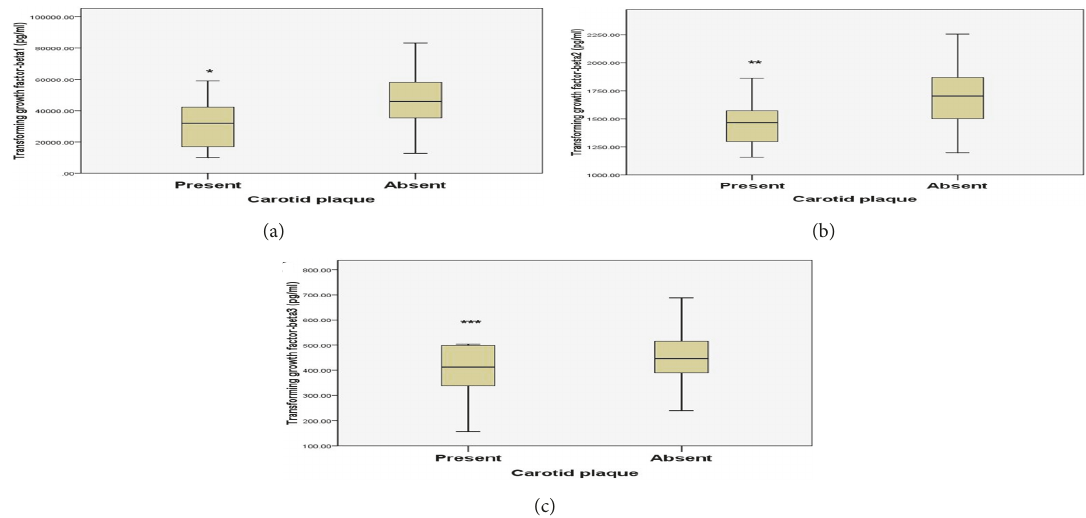
Figure 2: Comparison of serum transforming growth factor- 𝛽 1 (a), 𝛽 2 (b), and 𝛽 3 (c) between patients with carotid plaque and those without plaques. The boxes indicate median, 25th, and 75th percentile; whiskers represent data range; whisker caps indicate 5th and 95th percentile. Transforming growth factor- 𝛽 1, 𝛽 2, and 𝛽 3 levels were analyzed with Bio-Plex Pro (cid:3) TGF- 𝛽 Assays kit. Carotid plaque was defined as the echogenic structure protruding into the lumen with the distance between the media adventitia interface and the internal side of the lesion ≥ 1.2 mm. Serum transforming growth factor- 𝛽 1, 𝛽 2, and 𝛽 3 levels were compared between patients with carotid plaques and those without plaque, ∗ P = 0.016, ∗∗ P = 0.013, and ∗∗∗ P = 0.330 compared to those patients without plaque.